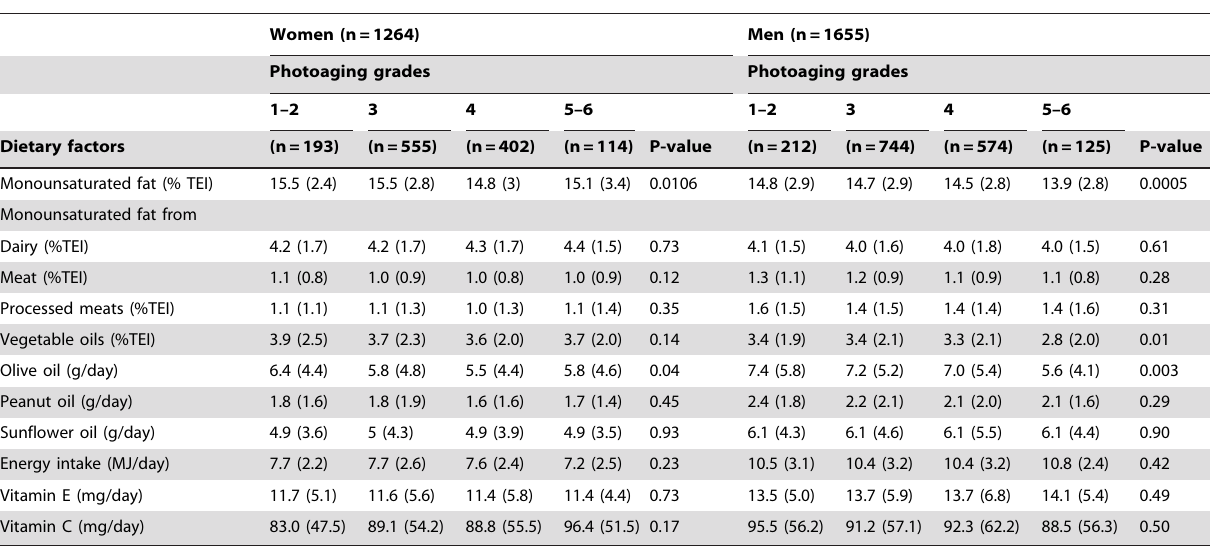
Table 2. Dietary factors according to photoaging